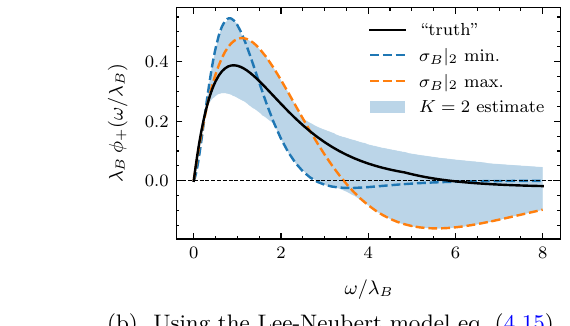
and the total variation of the parametrized LCDA. For the B and a small a into 0 /λ B 2